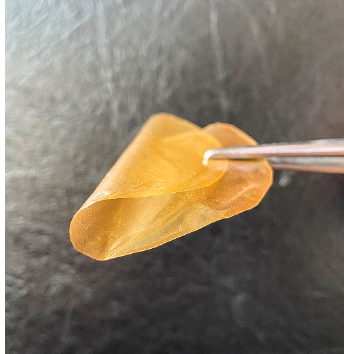
Figure 7. Flexibility of the quaternized PMP (sample Figure 7 . Flexibility of the quaternized PMP (sample 6).